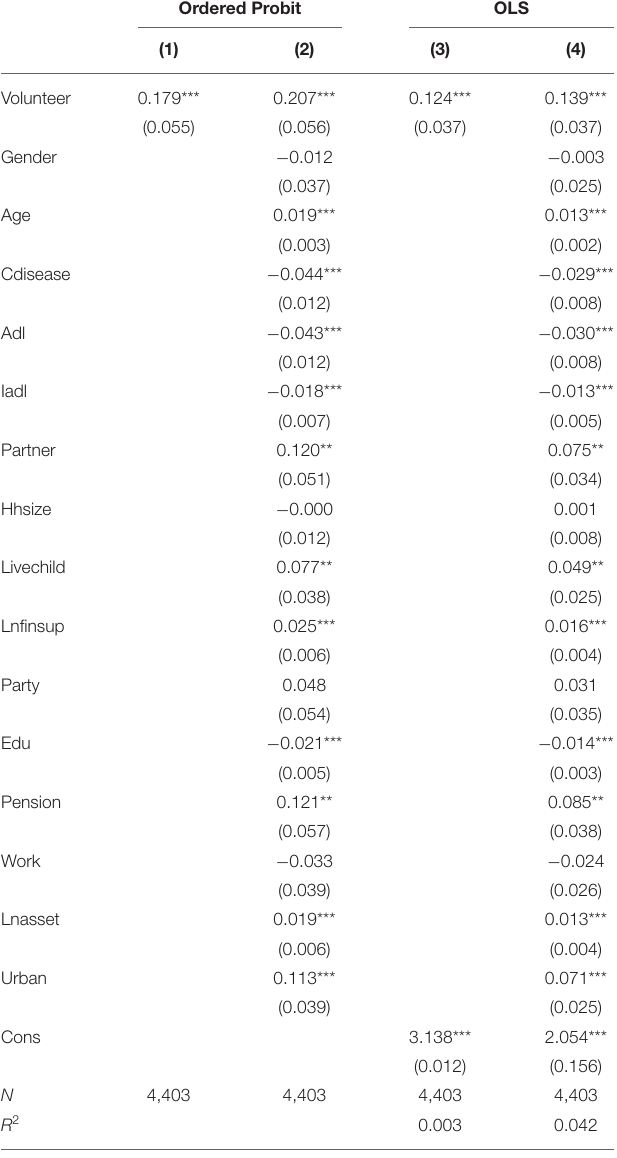
TABLE 3 | Basic regression results. Ordered